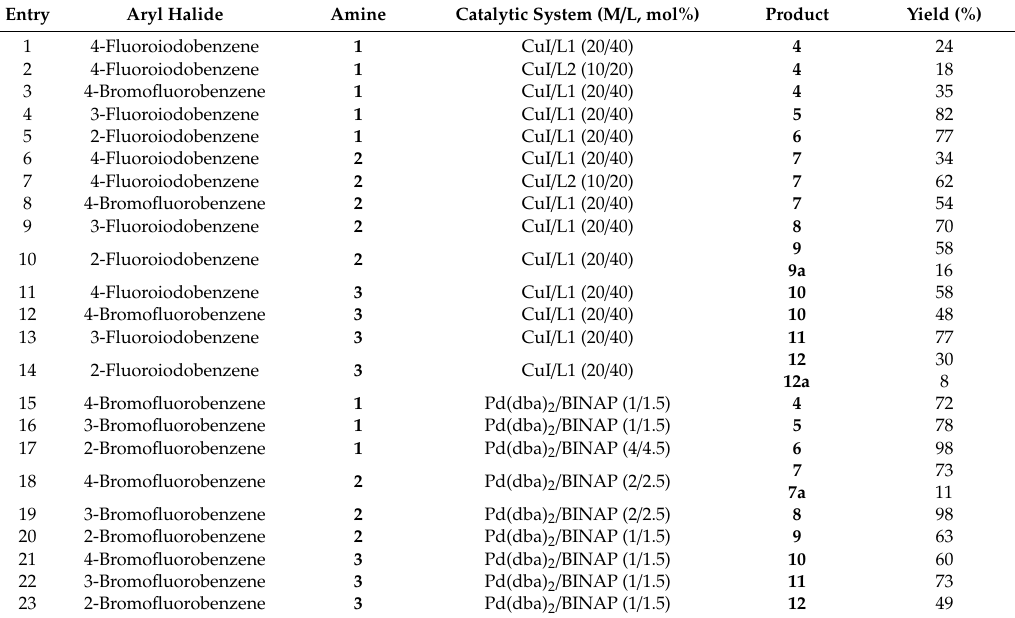
Table 1. Catalytic arylation of oxadiamines 1 – 3 with fluoroiodo- and